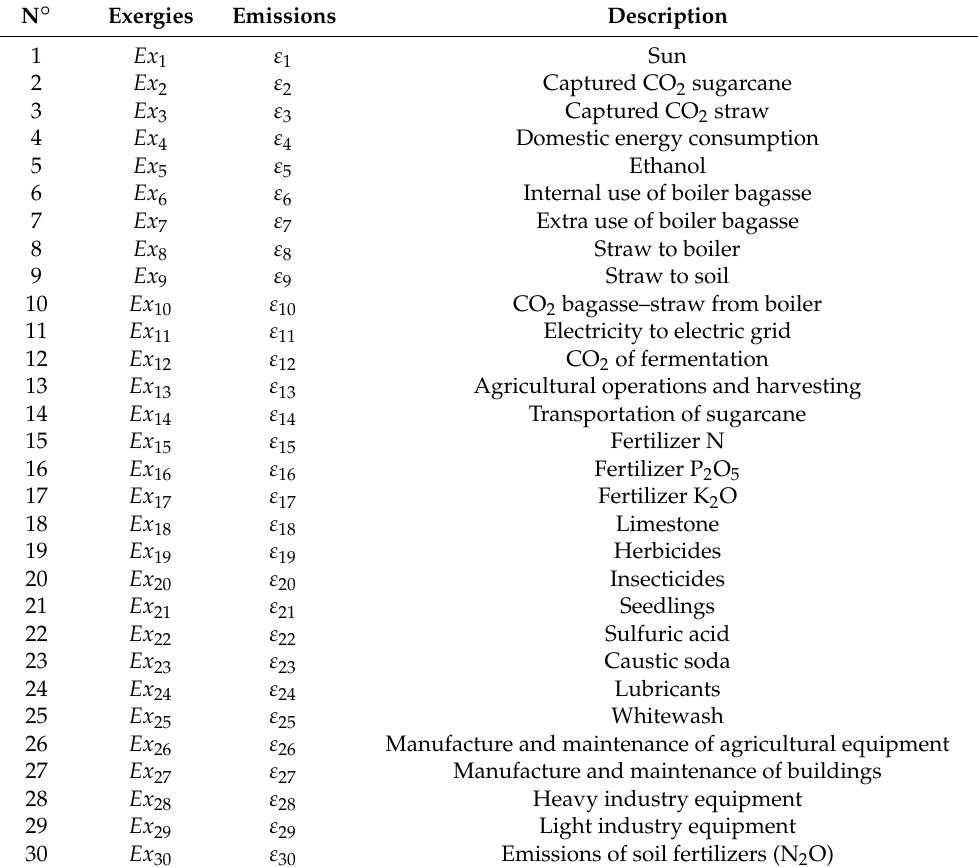
Table 2. Listed parts, exergy and